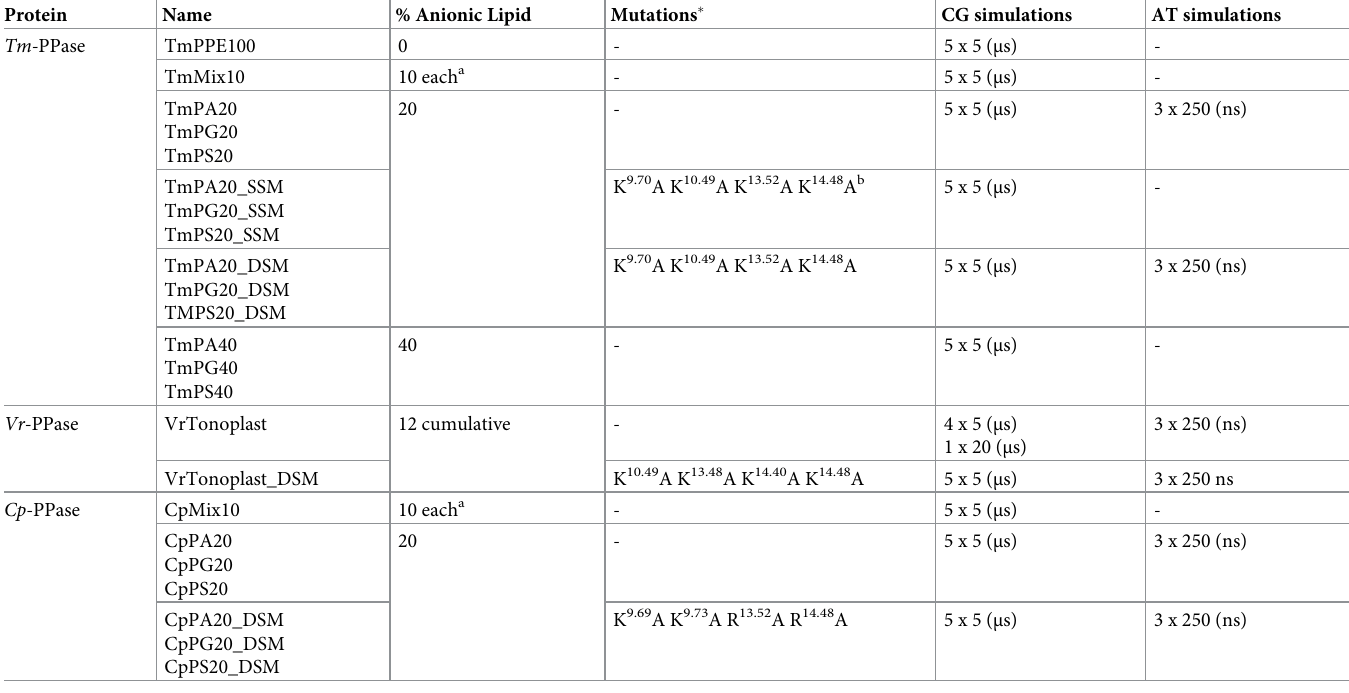
Table 2. Simulation